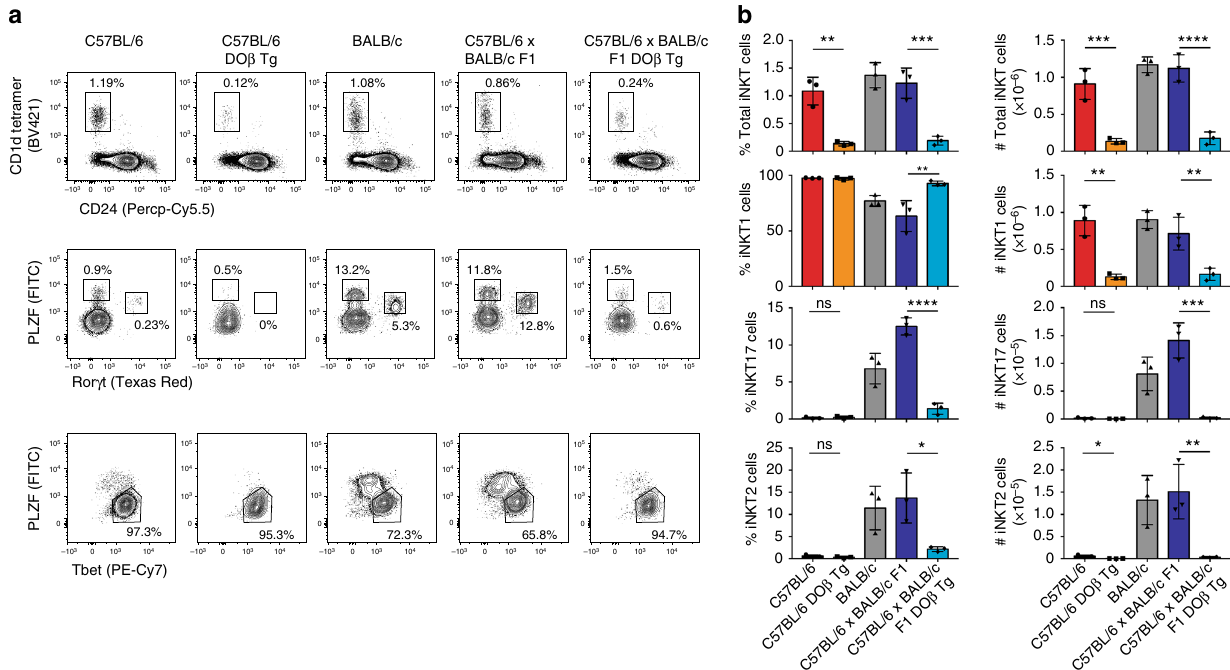
Fig. 2 Development of iNKT cell subsets in DO11.10 TCR β transgenic mice on the C57BL/6 or C57BL/6× BALB/c F1 background. a The thymi of 8-week- old C57BL/6, C57BL/6 DO11.10 TCR β transgenic, BALB/c, C57BL/6 × BALB/c F1, and BALB/c × C57BL/6 DO11.10 TCR β transgenic mice were stained with anti-CD24 mAbs, PBS57 – CD1d tetramers and mAbs speci fi c for the transcription factors PLZF, Ror γ t, and Tbet. Representative fl ow cytometry plots for the frequency of total mature iNKT cells and iNKT subsets in each genotype is shown. b Summary of the data shown in a with three mice per group. Data are mean ± SD. Signi fi cance was assessed using multiple comparison one-way analysis of variance (ANOVA) * p < 0.05; ** p < 0.01; *** p < 0.001; **** p < 0.0001; ns, not signi fi cant. For clarity purposes, the only statistics shown are between mice with or without expression of the DO11.10